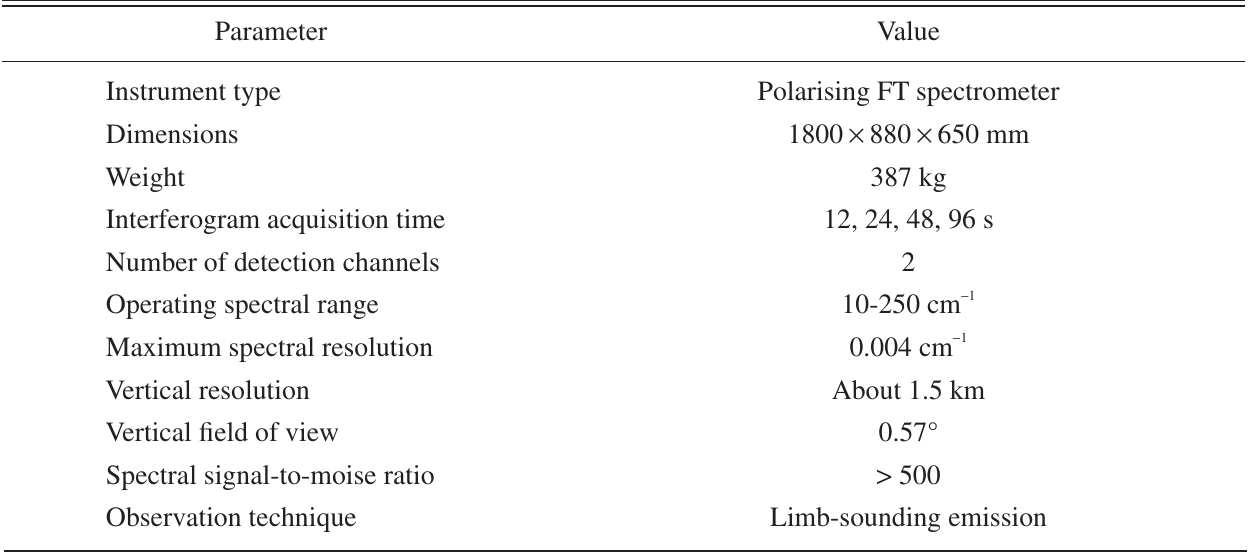
Table II. Characteristics of the SAFIRE-A Fourier transform spectrometer